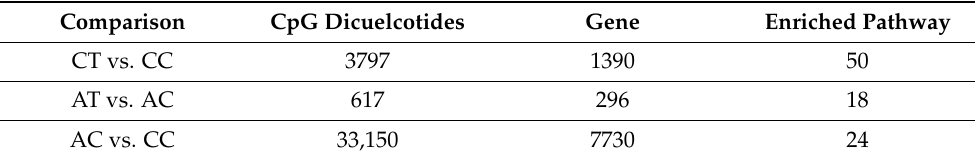
Table 1. The summary of significantly altered CpG dinucleotides, genes and enriched pathways. Comparison CpG Dicuelcotides Gene Enriched